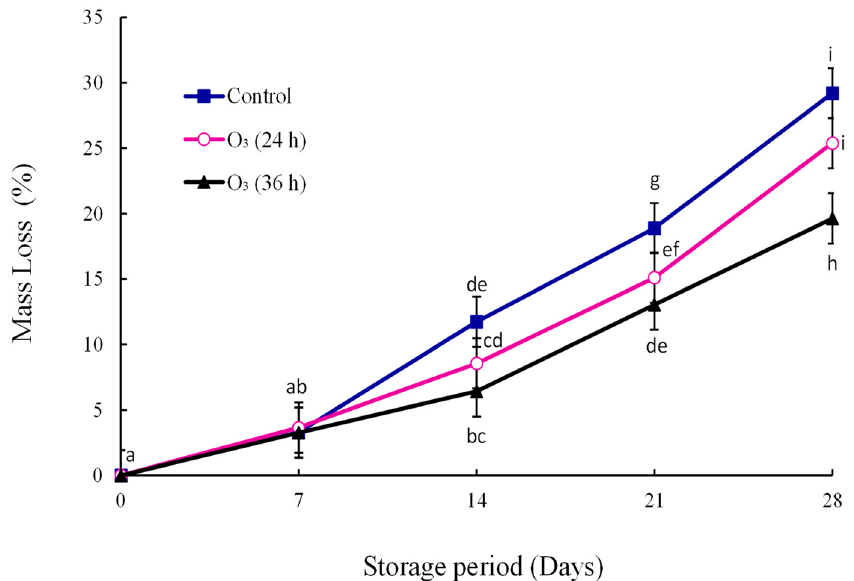
Figure 2. Effect of gaseous ozone (0.25 mg/L) on mango fruit mass loss (%) inoculated with L. theobromae , stored at 10 ◦ C for three weeks and ripened at ambient temperature for seven days ( p < 0.05; ± SE; n = 9). The letters a–i are used above or below the reported values. The means with the same letter are not significantly different (least significant difference = 1.92).